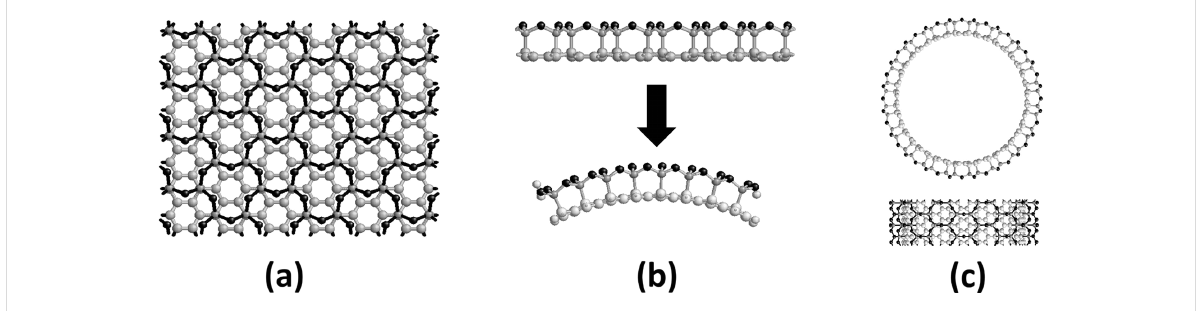
Figure 7: Superposition of the hexagonal carbon lattice and the six-membered SiO 4 rings. (a) Top view, (b) side view with the depiction of the spontaneous bending of the layers and the C–Si bonds and (c) a carbon nanotube is surrounded by a cylindrical SiO x (x = 5/2) layer. Carbon, oxygen, and silicon atoms are colored in light gray, dark gray, and black,